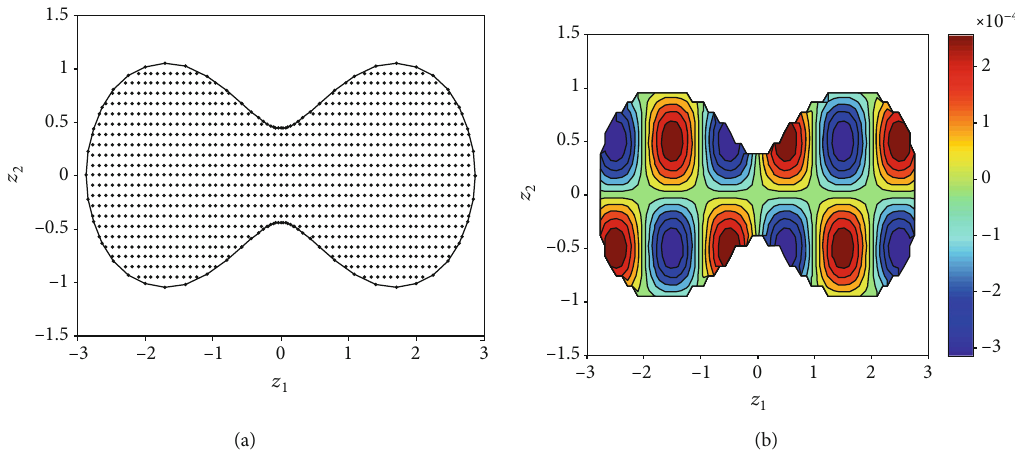
Figure 12: (a) Irregular domain and (b) numerical solution for the Problem 7.